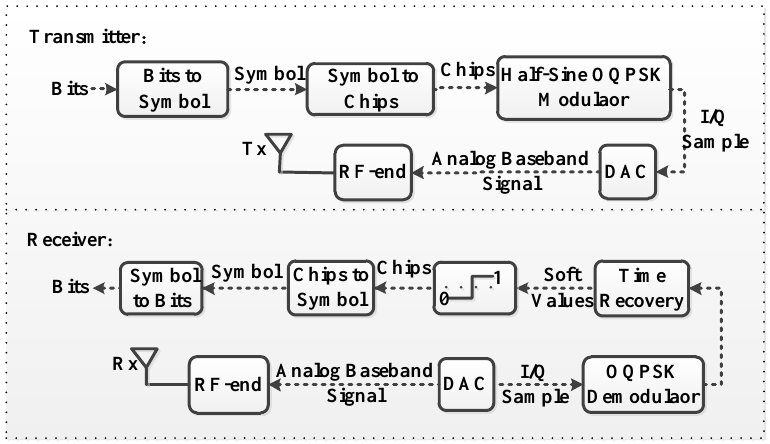
Figure 1. Physical layer of ZigBee transmitter and receiver.